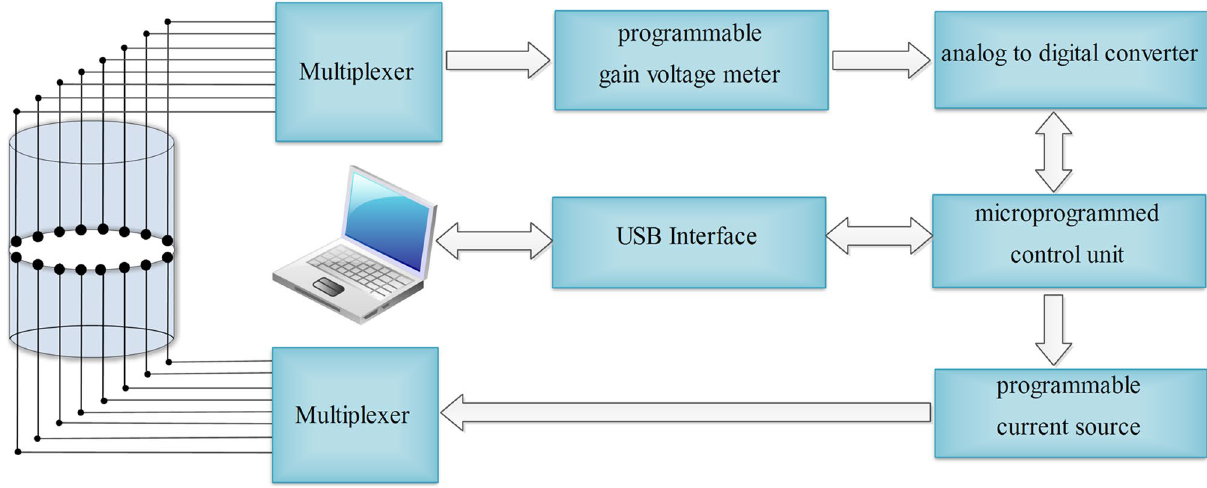
Figure 5. Diagram of the electrical impedance tomography (EIT) data acquisition